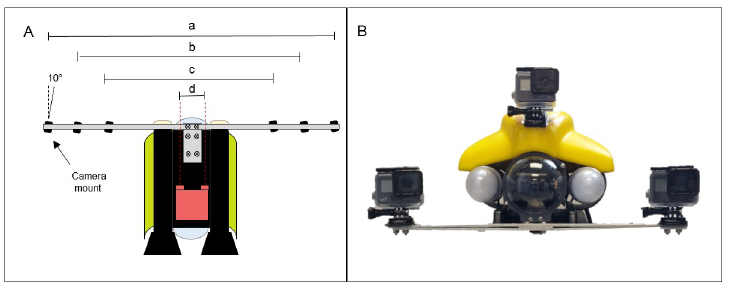
Fig 1. Stereo camera attachment and orientation. Schematic showing A) bottom view of the three stereo camera pairs mounted to the ROV at BDs of a) 762 mm (BD3), b) 610 mm (BD2), or c) 406 mm (BD1) and the d) RLS (75 mm BD) used to estimate model fish lengths in the pool experiment. Panel B indicates the front-view of the digital cameras (GoPro Hero5) mounted to the ROV in stereo at BD1 for use in the field experiment. Black rectangles in panel A indicate the mounting positions of the six GoPro Hero5 model cameras (3 pairs), each of which had 10˚ inward rotation.